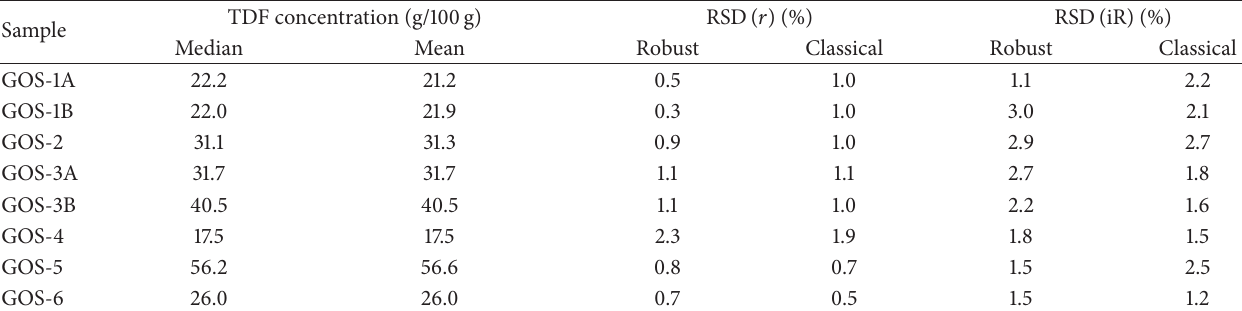
Table 4: Determination of TDF in GOS ingredients and precision data using both robust and classical